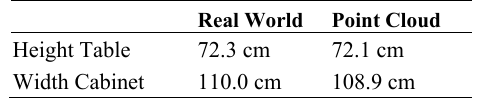
Table 3. Comparison of measurements of objects in the real